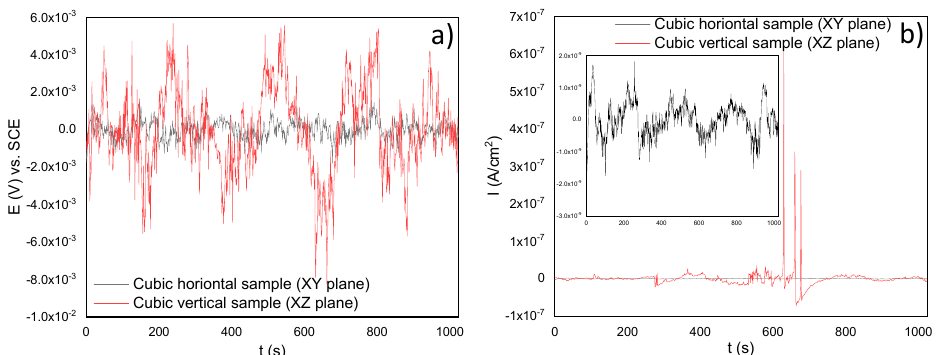
Figure 9. Time series in potential and current for the SLMed 316L SS in 20% H 2 SO 4 : ( a ) potential versus time and ( b ) current versus time.